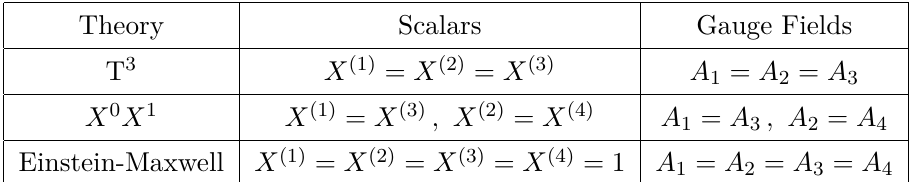
Table 1 . The three consistent truncations of 4d N = 2 U (1) 4 gauged supergravity. We will largely ignore the Einstein-Maxwell truncation since it has appeared previously in the literature, and